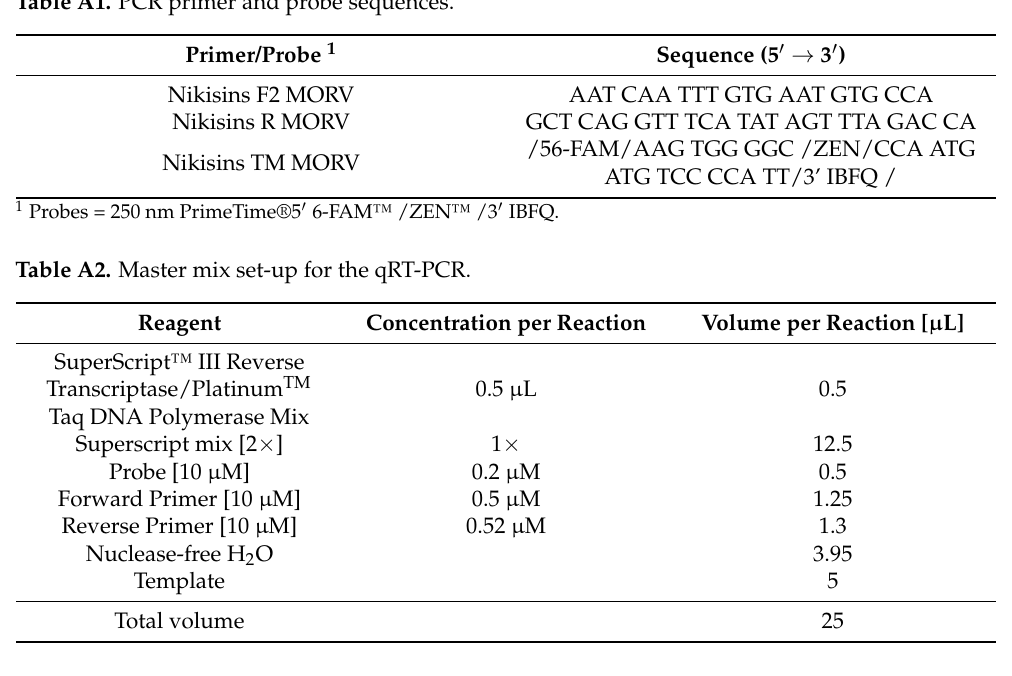
Table A3. Cycling parameters for qRT-PCRs with the Platinum TM Taq DNA Polymerase